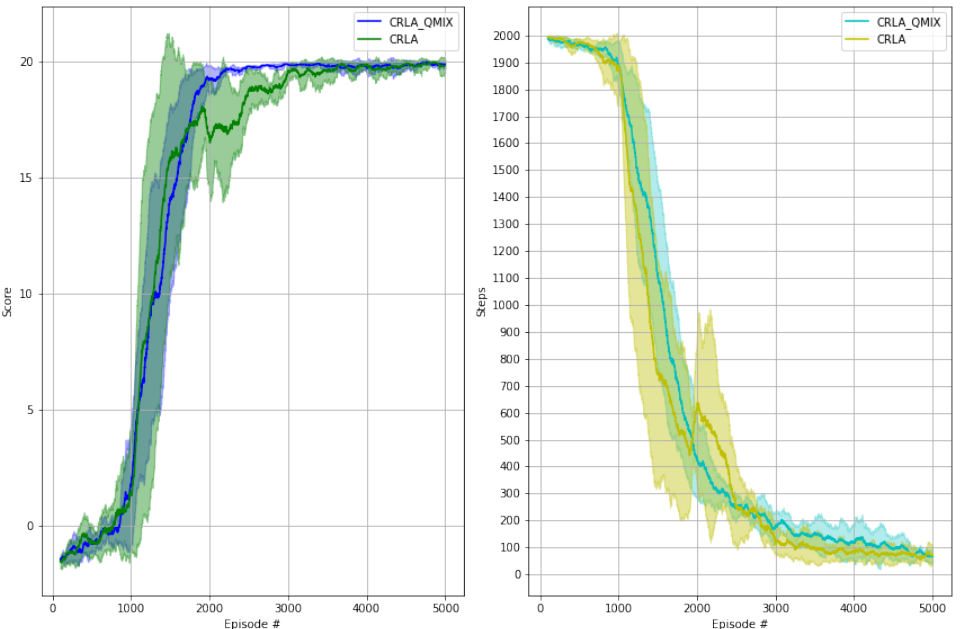
Figure 8. Performances of CRLA with and without QMIX on the 60-hosts